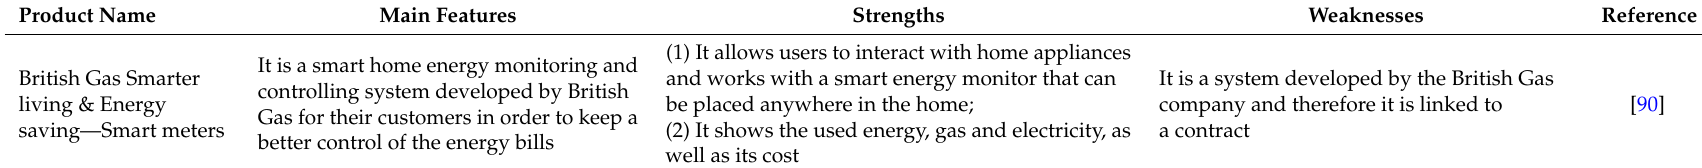
Table 6. Features, strengths, and weakness of the analyzed HA